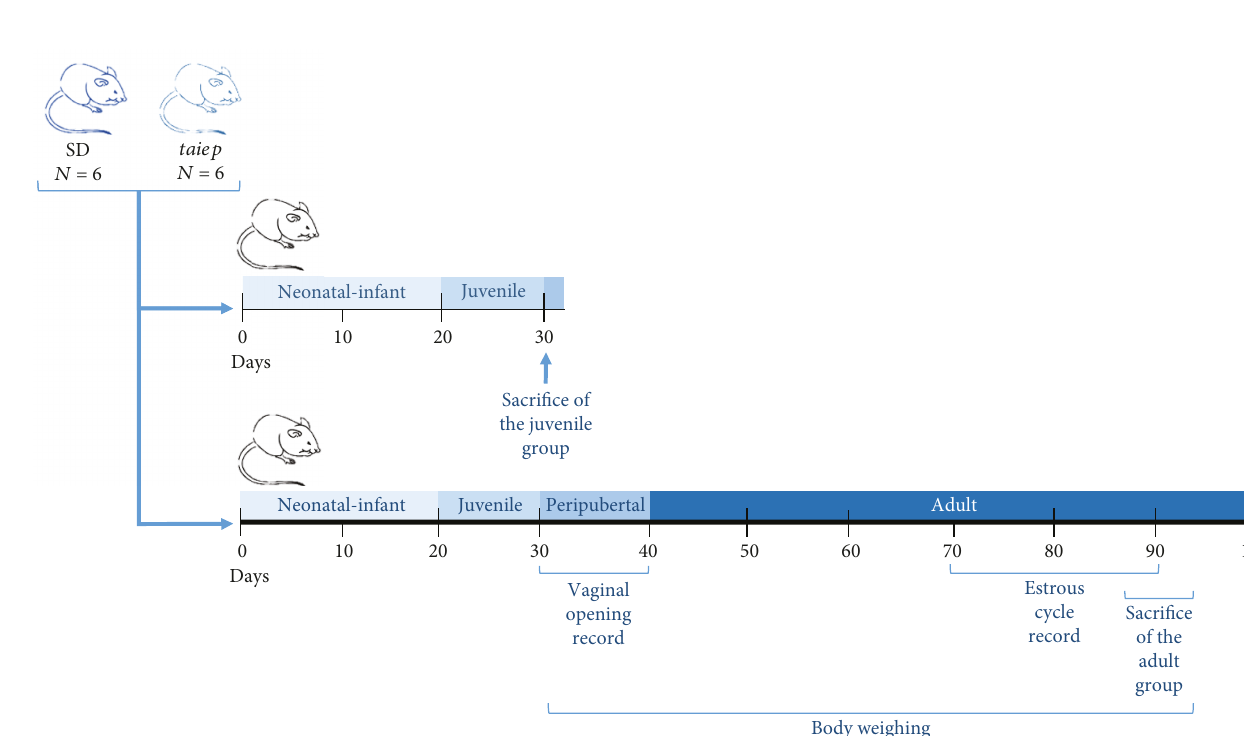
Figure 1: Experimental design. We used 6 taiep rats and 6 Sprague – Dawley (SD) rats divided into two groups: juvenile and adult. The rats in the juvenile group were sacri fi ced at the age of 30 days and those in the adult group were sacri fi ced in estrous at the age of 90 ± 5days. Vaginal opening records, body weighing, and estrous cycle records were acquired in the adult